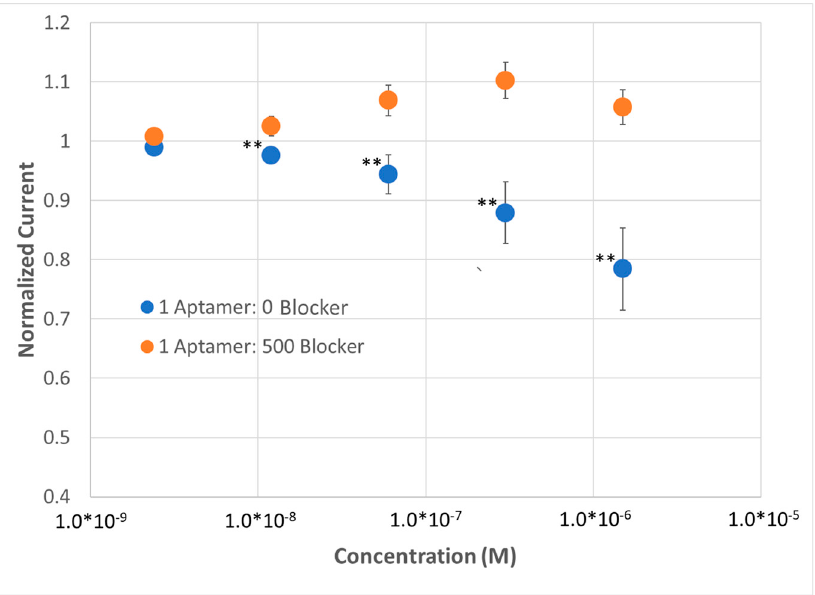
Figure 7. Demonstration of lysozyme aptasensor (n = 3) with a 6-carbon zwitterionic SAM using SWV at 10 Hz and a 100 µ M methylene blue redox reporter. p values < 0.05 (*), 0.01 (**) and 0.001 (***) determined using a two-tail t-test.